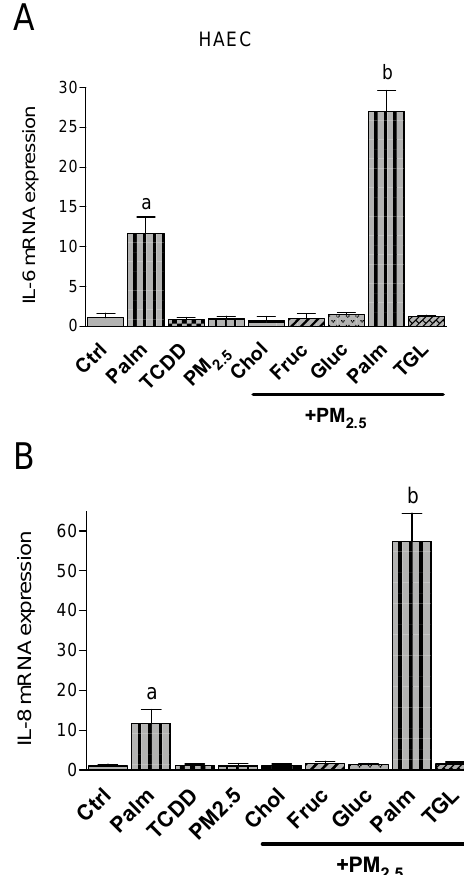
Figure 3. E ff ect of nutritional compounds on PM 2.5 -induced cytokine expression in HAEC. Cells were treated with 1 nM TCDD and 10 µ g / mL PM 2.5 for 24 h. The e ff ect of nutritional factors cholesterol (Chol, 10 µ g / mL), fructose (Fruc, 25 mM), glucose (Gluc, 25 mM), palmitic acid (Palm, 5 µ M), and triglyceride (TGL, 10 µ g / mL) was tested in presence of PM 2.5 after 24 h of treatment. Control cells were treated with the corresponding vehicle. The mRNA expression of ( A ) IL-6 and ( B ) IL-8 was analyzed by qPCR. The expression was corrected against the housekeeping gene β -actin. a significantly higher than Ctrl; b significantly higher than cells treated with PM 2.5 only p < 0.05.